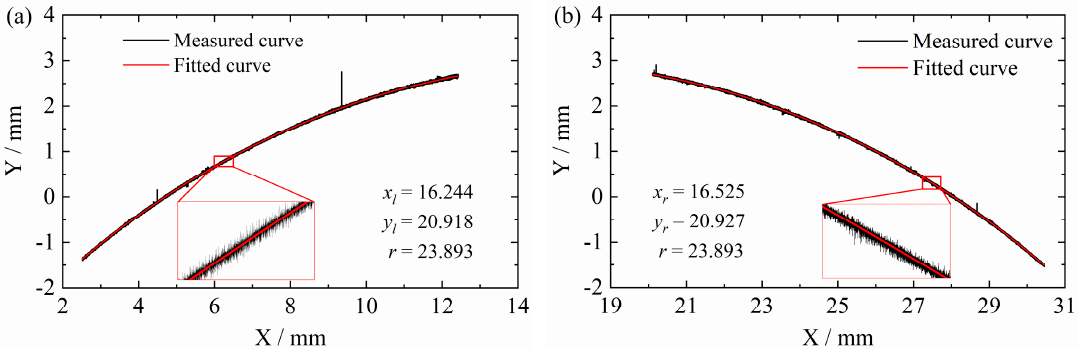
Figure 7. Principle of biarc curve-fitting error analysis for the spherical diamond wheel: ( a ) profile fitting of the left side, ( b ) profile fitting of the right side.